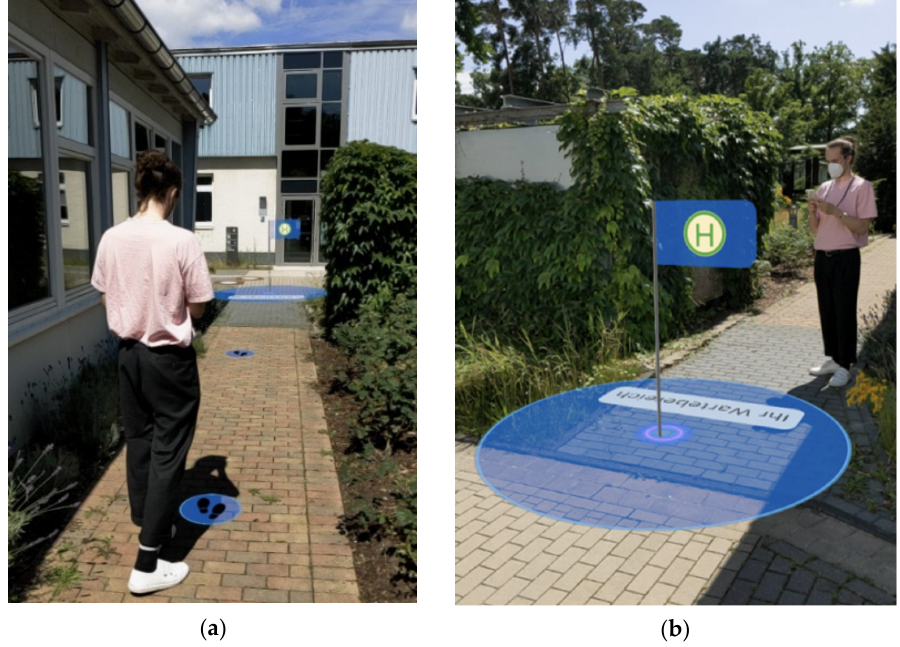
Figure 5. Participant during AR testing in second user study. Photo arrangements of AR functionality for representational reasons. ( a ) Participant follows pathway elements in order to navigate toward vStop. ( b ) Participant has reached vStop and is positioned right before the labeled waiting area.